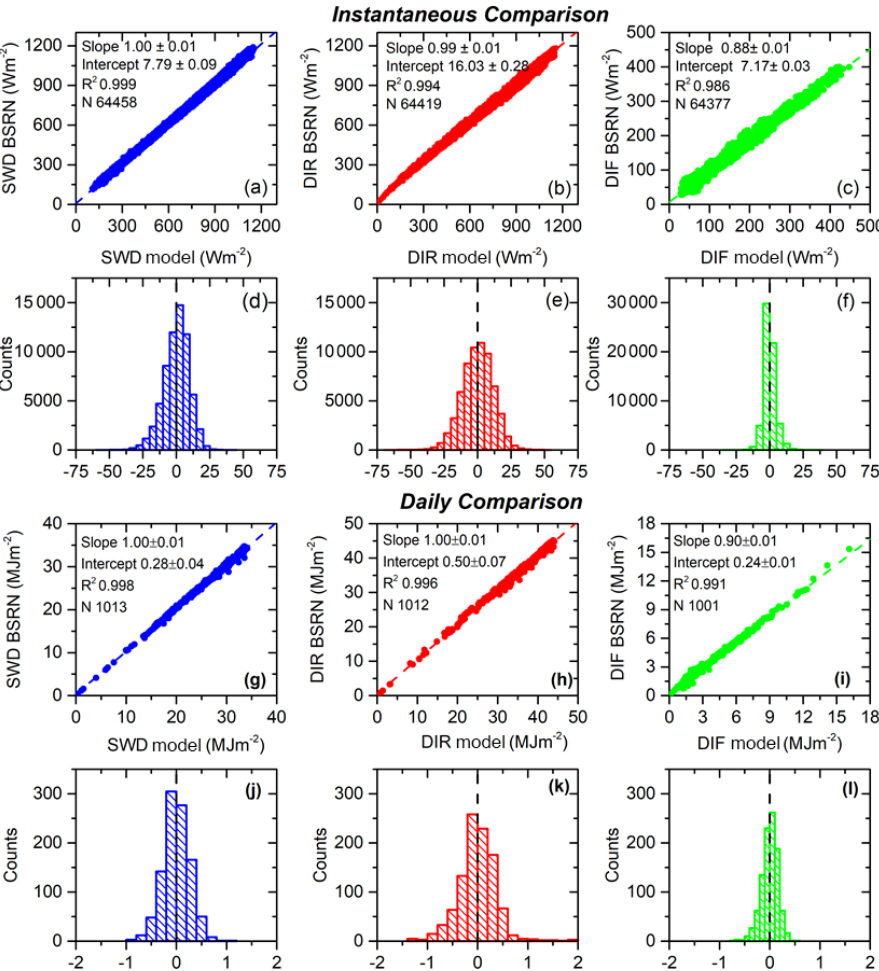
Figure 10. Scatterplots and histograms of the instantaneous (Wm − 2 ) and daily (MJm − 2 ) radiation measurements and simulations for the period 2009–2017: (a, d, g, j) SWD, (b, e, h, k) DIR and (c, f, i, l) DIF. The fitting parameters are shown in the legend. Table 7. Statistics for the bias between instantaneous and daily SWD, DIR and DIF simulations and measurements at IZA BSRN for the period 2009–2017. MB is mean bias; SD is standard deviation; RMSE is root mean square error. MB (%) SD (%) RMSE (%) Instantaneous Daily Instantaneous Daily Instantaneous Daily SWD − 1 . 68 − 1 . 24 2.26 1.03 2.28 1.58 DIR − 1 . 57 − 1 . 82 1.92 1.17 2.00 2.07 DIF 0.08 0.84 7.90 8.69 9.89